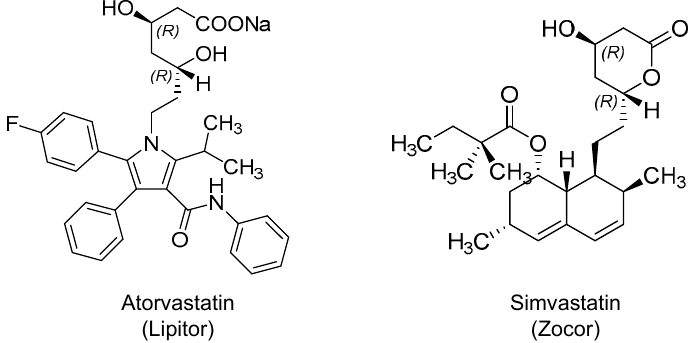
Figure 4. The chemical structures of HMG CoA reductase inhibitors being tested in clinical trials for potential therapeutic benefits in COVID-19 patients.